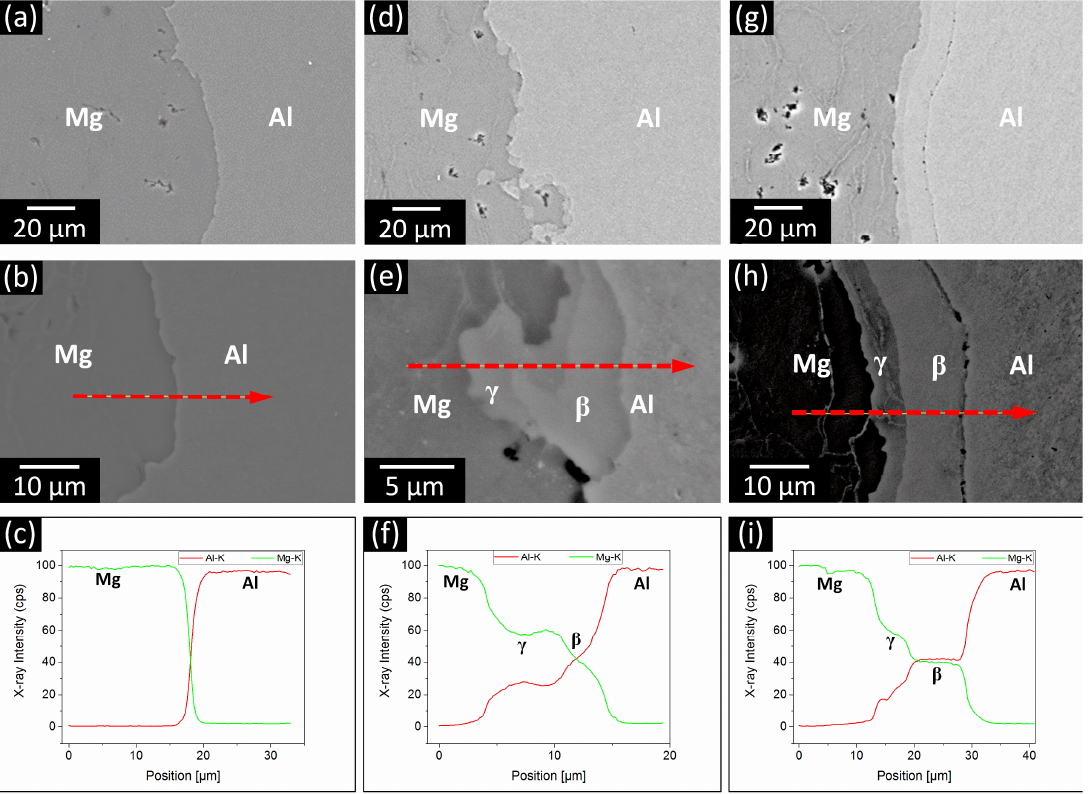
Figure 6. The SEM micrographs and EDX elemental concentration profiles for the bilayer Al-Mg composites hot-pressed at ( a – c ) 573, ( d – f ) 623 and ( g – i ) 673 K. The dashed red arrows represent the scanned EDX line.